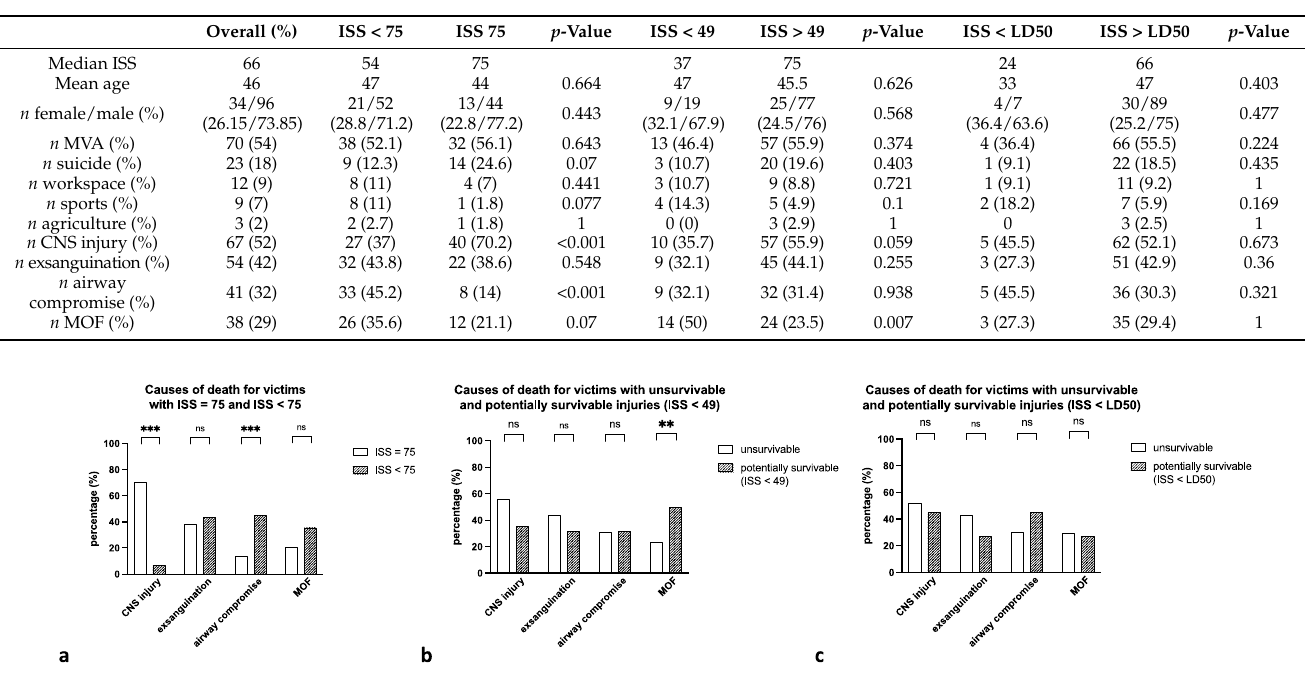
Figure 5. Relative frequencies of causes of death for ( a ) maximal (clear) vs. submaximal (patterned) trauma, ( b ) unsurvivable (ISS > 49, clear) vs. potentially survivable (ISS < 49, patterned) trauma, and ( c ) unsurvivable (ISS > LD50, clear) vs. potentially survivable (ISS < LD50, patterned) trauma. Relative frequency of CNS injury was always higher in the suspected higher traumatized group but reached significance only in the comparison of maximal to submaximal trauma ( a ). In turn, airway compromise was more frequently observed in victims sustaining potentially survivable injury with significance only when comparing maximal to submaximal trauma ( a ). Similarly, MOF was more frequent in submaximal ( a ) and potentially survivable ( b , c ) trauma. *** p < 0.001, ** p < 0.01, ns: not significant.